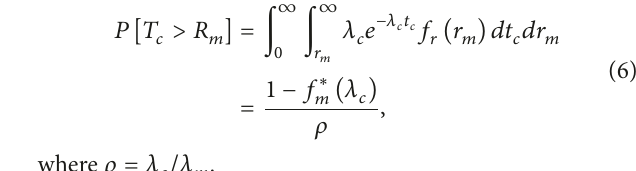
Figure 4: State-transition diagram of the DBIR scheme using SMP